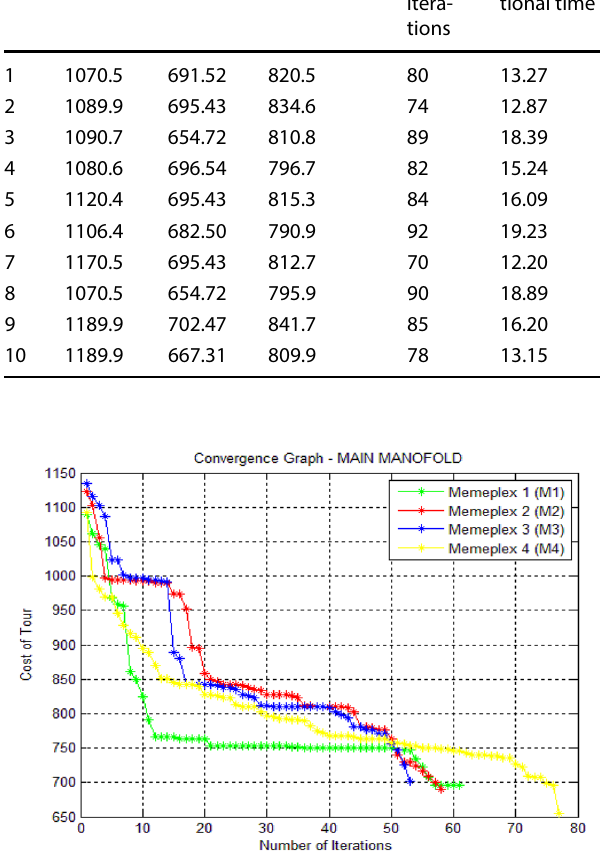
Fig. 5 Holes location and distances of top plate of manifold